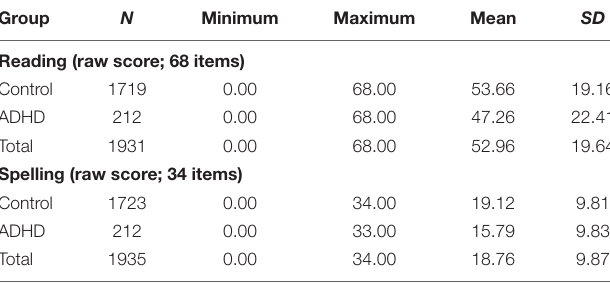
SD, standard deviation; N, sample size; ADHD, attention deficit/hyperactivity disorder group.